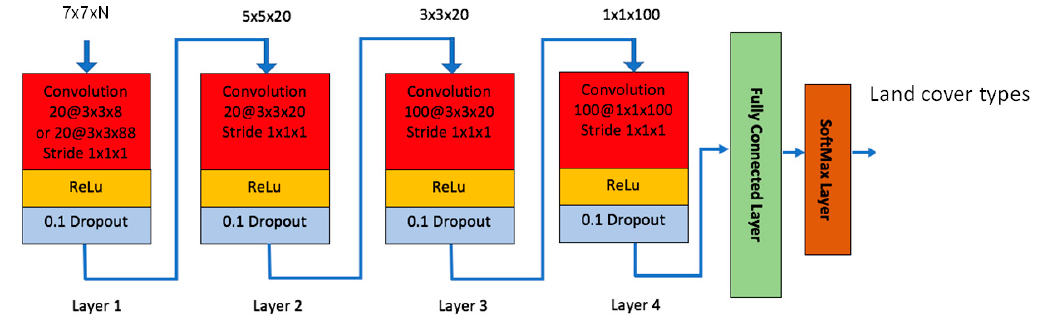
Figure 1. Our customized conventional neural network (CNN) model.